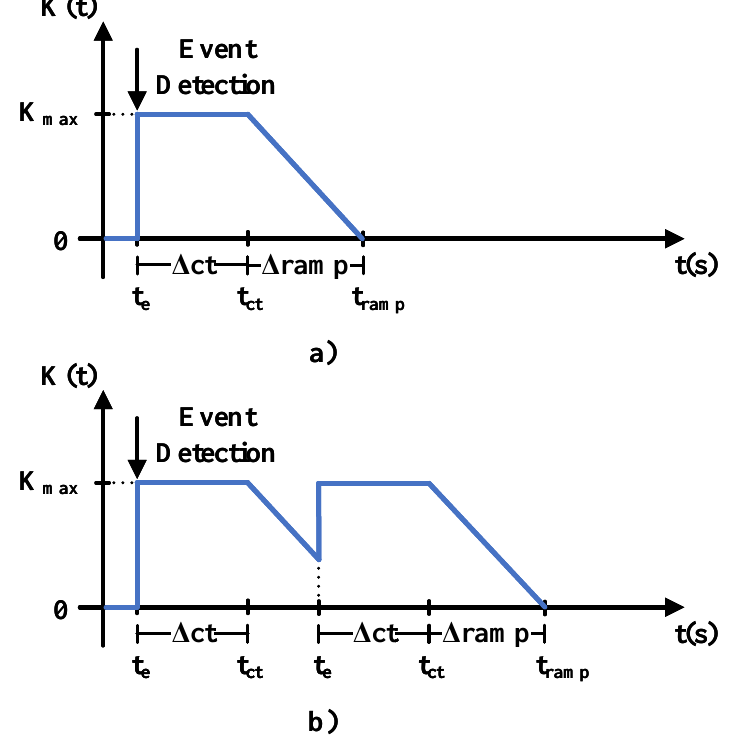
Figure 8. Time-dependent protocol for: ( a ) single event. ( b ) Multi-event